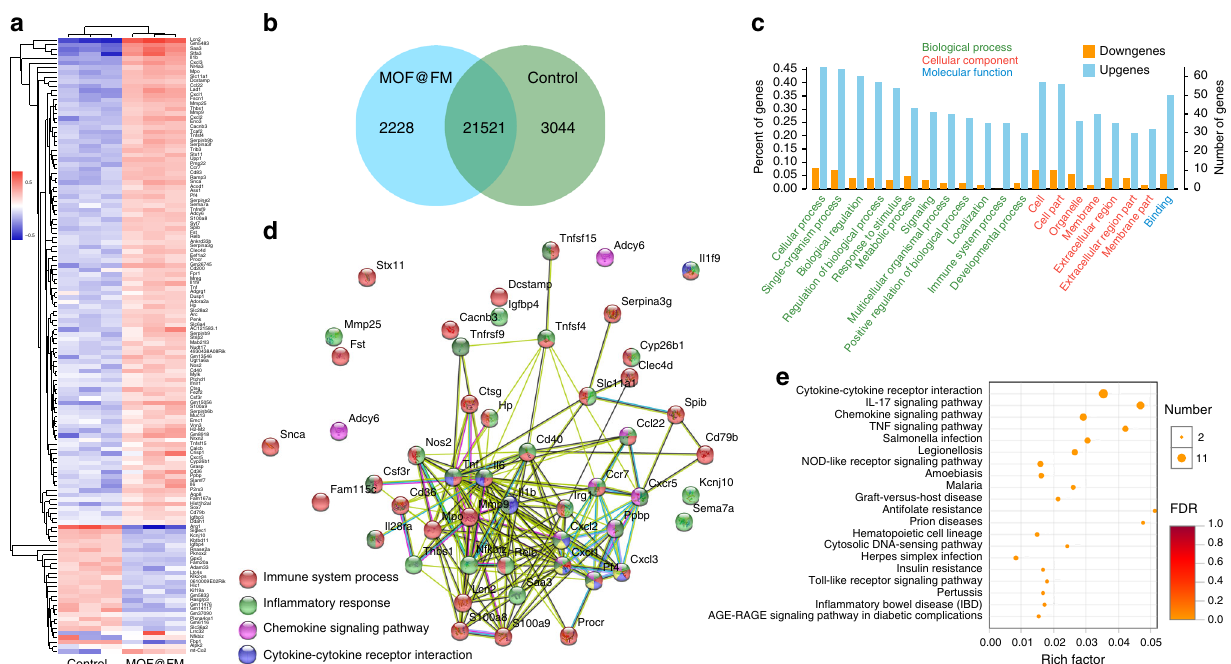
Fig. 4 Transcriptome analyses of MOF@FM induced DCs. a Heat map showing signi fi cantly upregulated and downregulated genes of DCs after MOF@FM treatment (fold change ≥ 2 and p < 0.05). b Venn diagram of a primary transcript between MOF@FM and PBS. c The changes of genes associated with biological process, cellular component, and molecular functions based on GO annotation. d The analyses of functional interaction network of MOF@FM regulated genes by using the Search Tool for the Retrieval of Interacting Genes/Proteins (STRING) algorithm. e KEGG pathway analysis for immune response associated different genes. Measurements were taken from distinct samples ( n = 3). Source data are provided as a Source Data fi